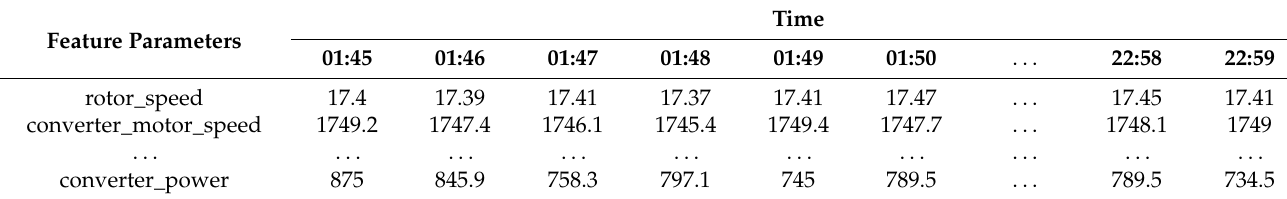
Figure 3. Wind turbine system diagram. Table 2. Original data of the wind